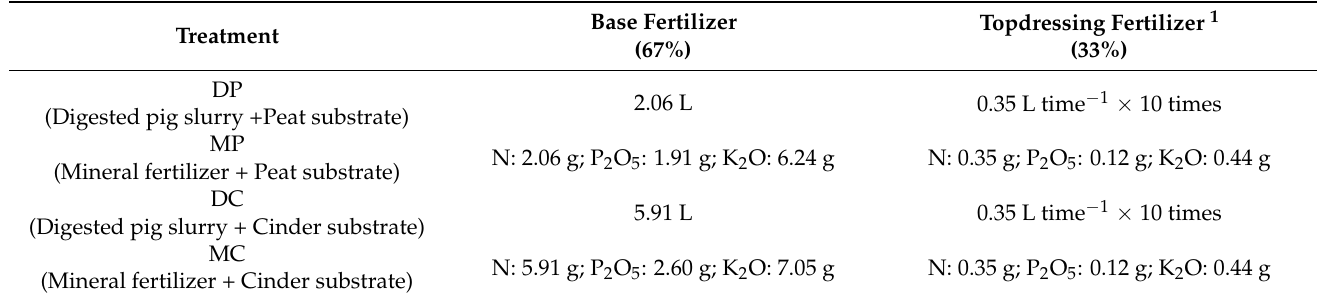
Table 2. The amount of digested pig slurry and chemical fertilizer applied in the four